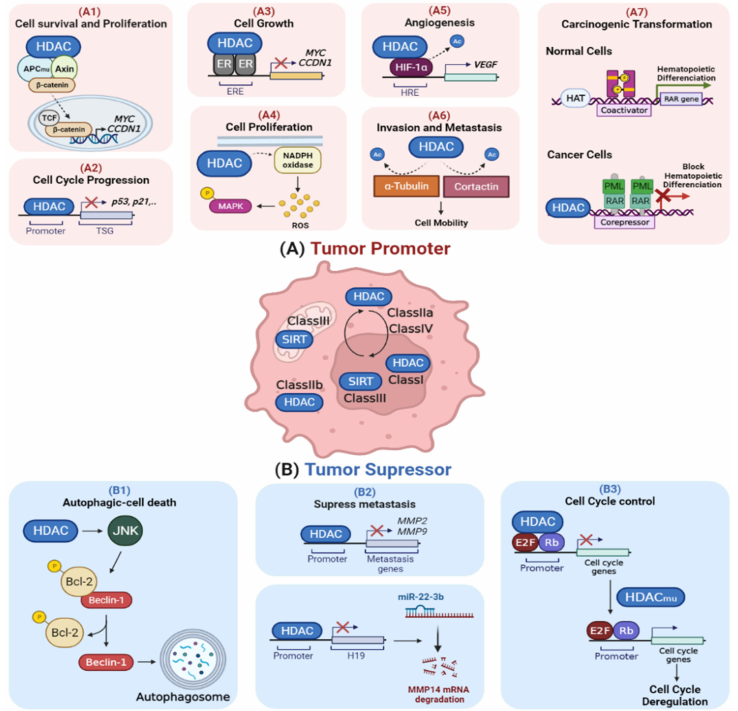
Figure 1. HDACs as tumor promoters and suppressors. ( A ) HDACs are overexpressed in cancer, which promotes cellular proliferation and suppresses apoptosis and cell cycle arrest. (A1) Some HDACs (e.g., HDAC2) stabilize the beta-catenin complex, boosting cell survival and proliferation. (A2) HDACs are involved in the disruption of cell cycle checkpoints by obstructing the expression of tumor suppressor genes such as p53 and p21. (A3) Certain HDACs, such as HDAC1, reduce the transcription activity of estrogen receptor- α (ER- α ), resulting in growth promotion. (A4) HDACs (e.g., HDAC6) increase the activation of MAPK through inducing the production of reactive oxygen species (ROS) via NADPH oxidase, thus promoting cell proliferation and survival. (A5) Under hypoxia, HDACs (e.g., HDAC1) stabilize HIF-1 α through deacetylation, which, in turn, activates the transcription of genes involved in oxygen delivery, energy metabolism, angiogenesis, and apoptosis. (A6) The deacetylation of cell motility proteins (tubulin and cortactin) by HDACs (e.g., HDAC6) drives the progression of a primary tumor to invasion and metastasis. (A7) In hematological malignancies, PML-RAR oncofusion proteins act as altered transcription factors, which aberrantly recruit HDACs to the promoter site of retinoic acid (RA) genes, thus suppressing myeloid differentiation and causing malignant transformation. ( B ) Some HDACs have tumor suppressor activities and they are genetically downregulated in cancer. (B1) HDACs suppress tumor growth through activating JNK-mediated Beclin1 dissociation from Bcl-2 to induce caspase-independent autophagy death. (B2) HDACs (e.g., HDAC10) inhibit invasion and metastasis through reducing the histone acetylation level at the promoter sites of the matrix metalloproteinases (MMP2 and MMP9) genes, thereby suppressing their expression. Additionally, HDACs (e.g., HDAC2) suppress cancer metastasis through inhibiting expression of LncRNA H19, a miR-22-3P sponge that upregulates the expression of MMP14, by histone H3K27 deacetylation at its promoter site. (B3) Some HDACs (e.g., HDAC1) are involved